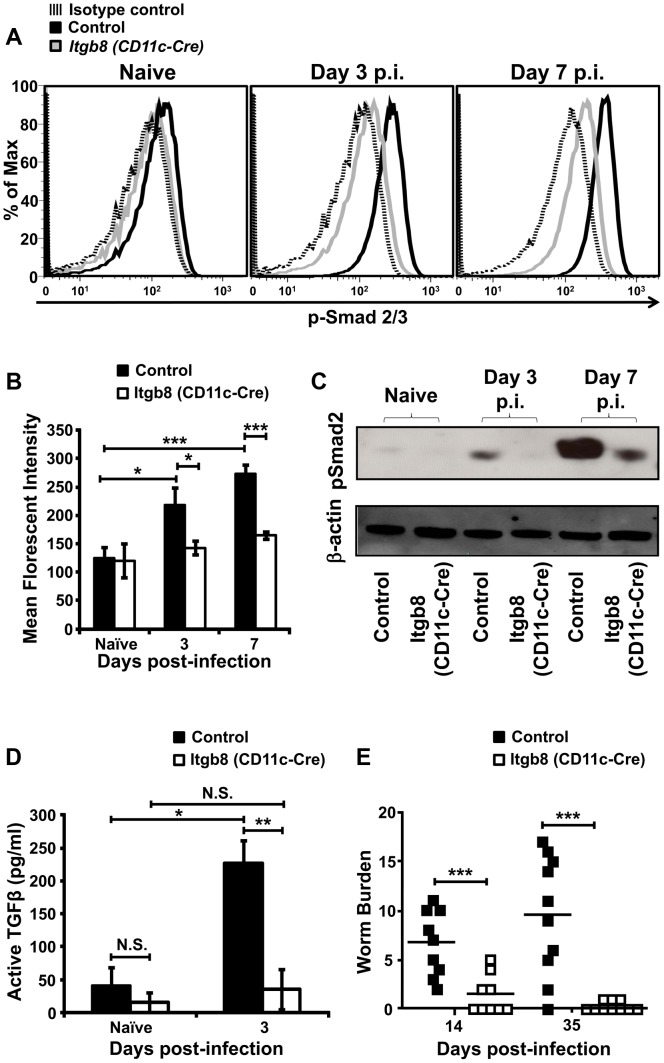
Mice lacking the TGFβ-activating integrin αvβ8 on DCs are protected from a chronic T. muris infection.(A) Representative flow cytometry plots and (B) average MFI values for p-Smad 2/3 staining in CD4+ T-cells from control and Itgb8 (CD11c-Cre) mice at different times after infection of mice with a chronic dose of T. muris eggs. Data (n = 5–8) are from three independent experiments performed. (C) Western blot analysis of p-Smad2/3 and β-actin in purified CD4+ T-cells from control and Itgb8 (CD11c-Cre) mice at different times during infection with a chronic dose of T. muris. Data representative of two independent experiments. (D) TGFβ activation by intestinal DCs isolated from control or Itgb8 (CD11c-Cre) mice, from naive mice or day 3 post-infection (p.i.) with a chronic dose of T. muris eggs, detected by co-culture with an active TGFβ reporter cell line [15]. Data (n = 3–4) are from three independent experiments performed. (E) Worm burdens from control and Itgb8 (CD11c-Cre) mice at day 14 and 35 p.i. with a chronic dose of T. muris eggs. Data (n = 9–10 mice per group) are from at least two independent experiments performed. *, P<0.05, ***, P<0.005 via Kruskal–Wallis (B) and Student's t-test (D and E) for the indicated comparisons between groups, error bars represent SE of means.